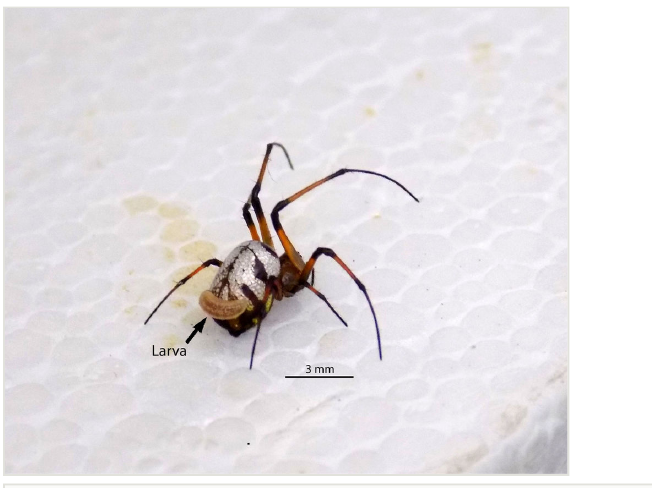
Figure 1. Adult female of Leucauge henryi containing a larva of Hymenoepimecis manauara attached on its abdomen.